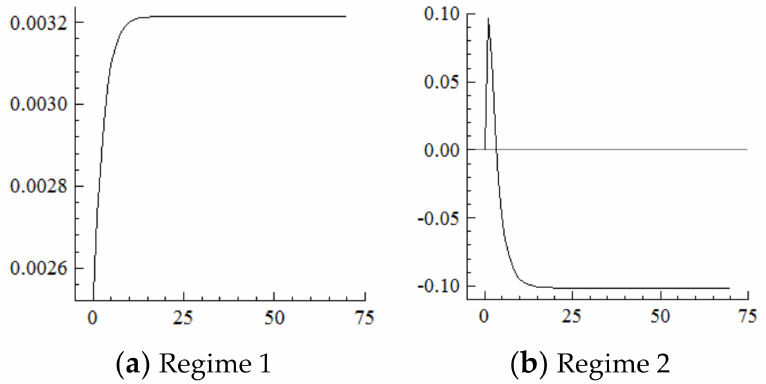
Figure 11. Cumulative Impulse Response of Investment to Population Aging Shocks.